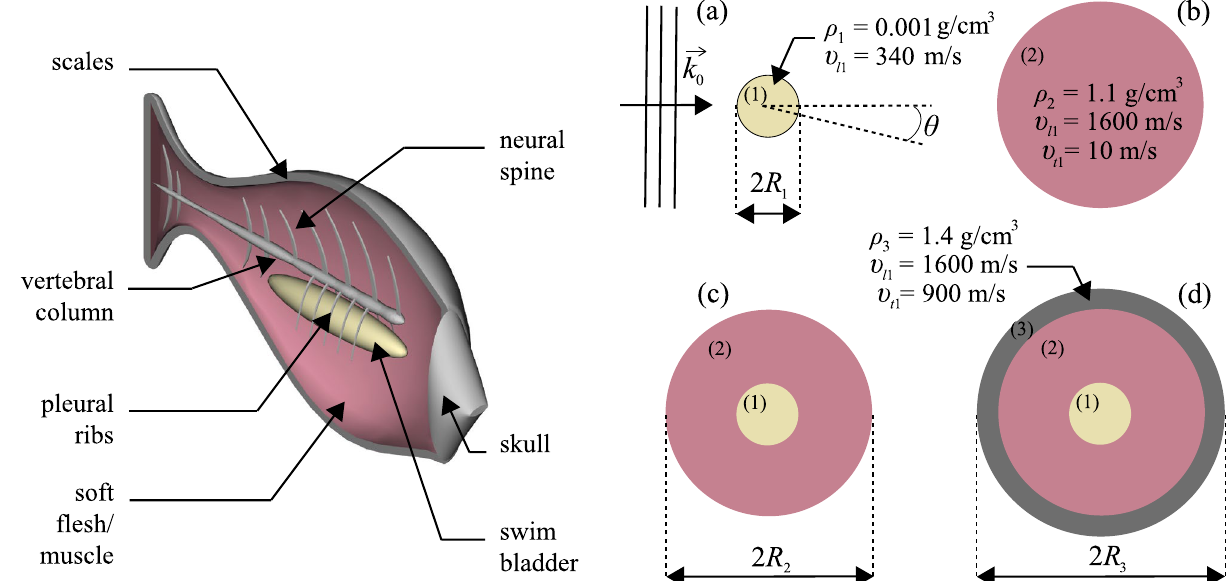
Figure 2. On the left: schematic representation of a sea bream body. On the right: models ( a )–( d ) used for the energy velocity